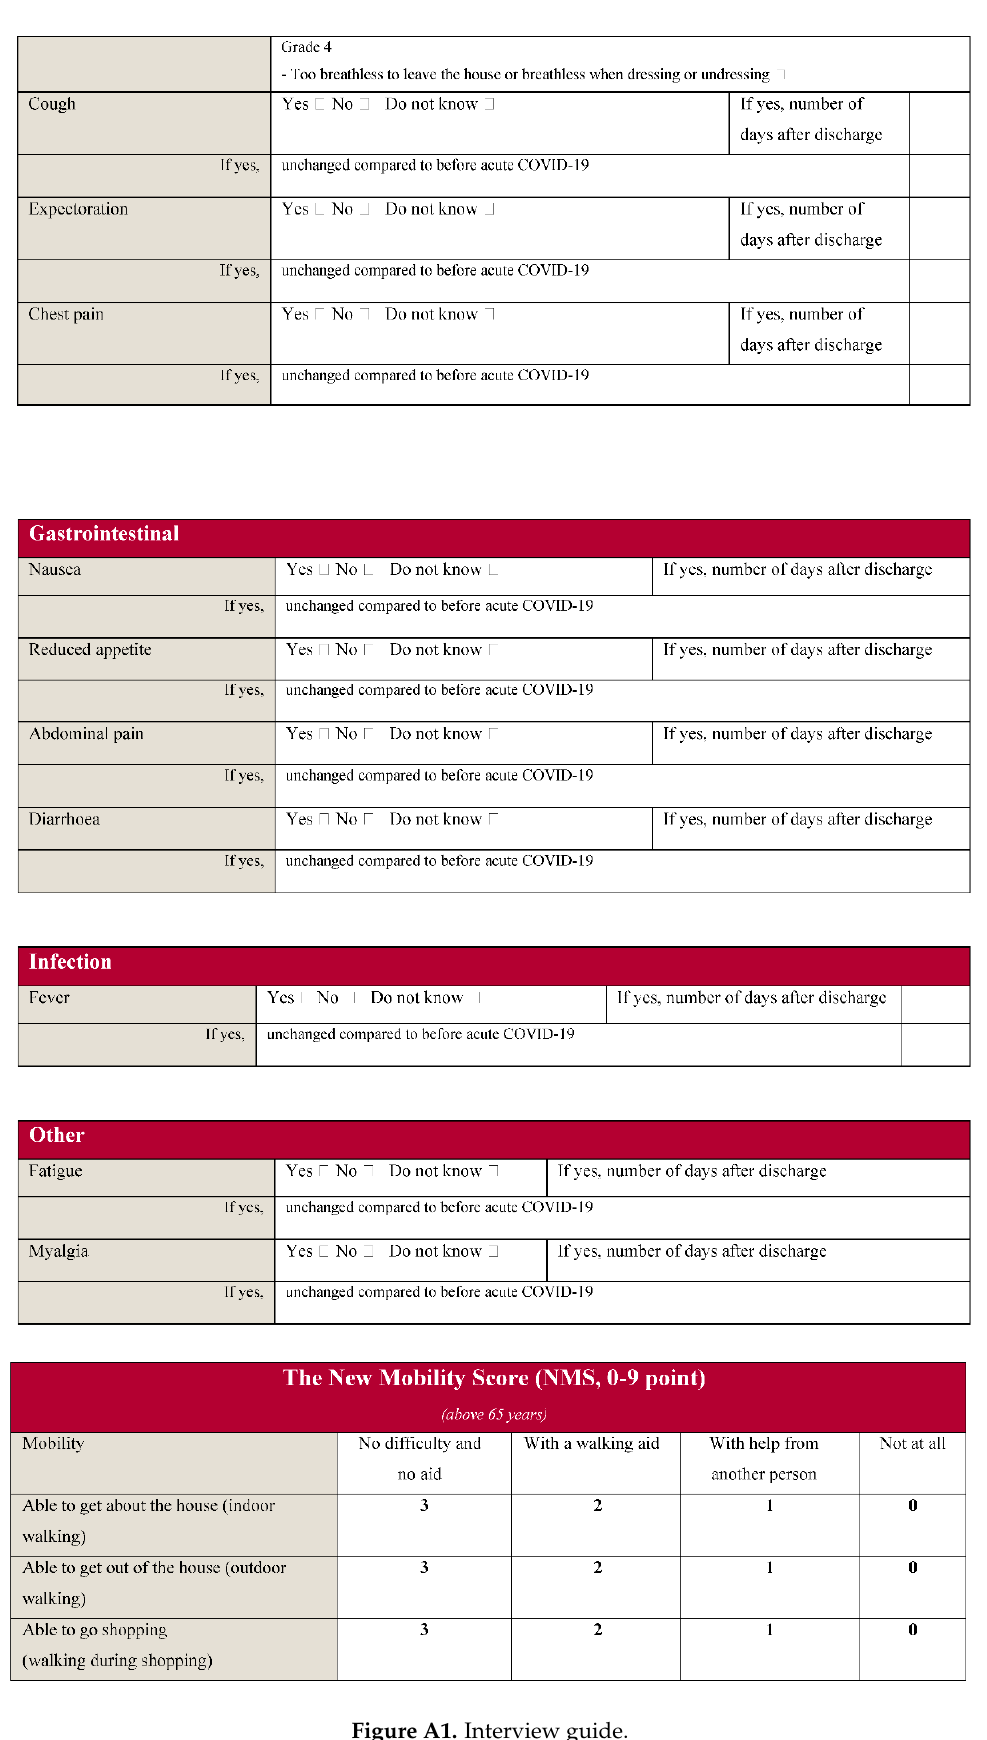
Figure A1. Interview guide.